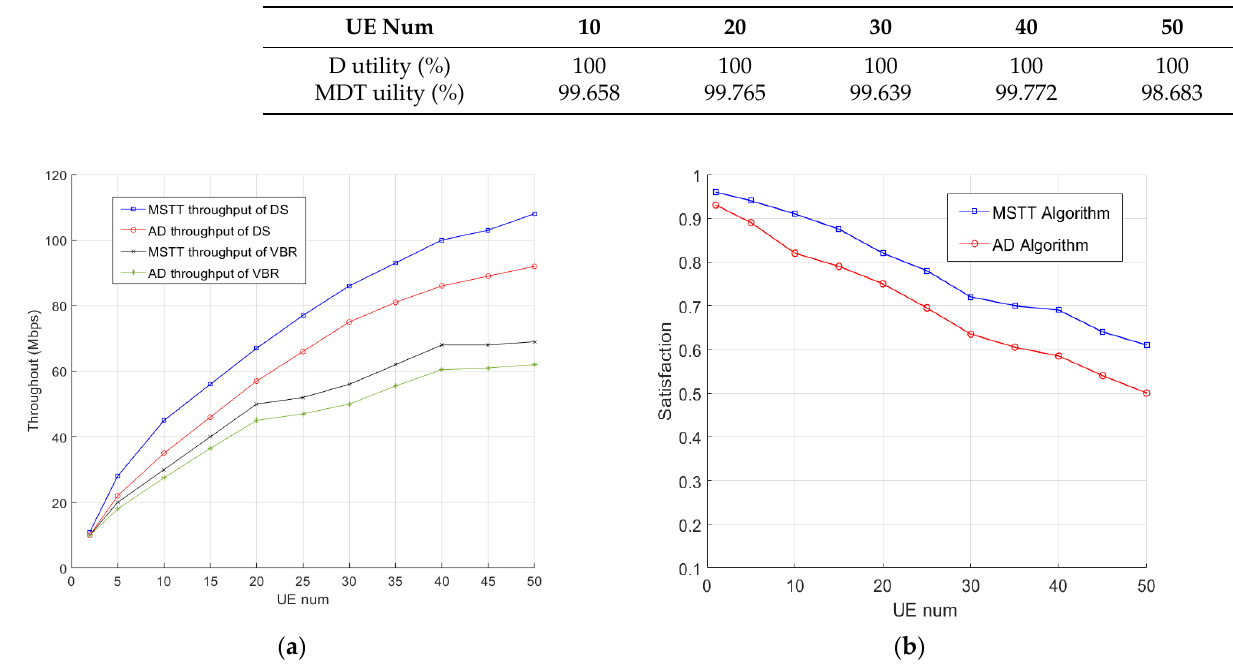
Figure 5. ( a ) Average throughput of VBR and DS services. ( b ) Average satisfaction of VBR and DS services. Table 2. Satisfaction of CBR.